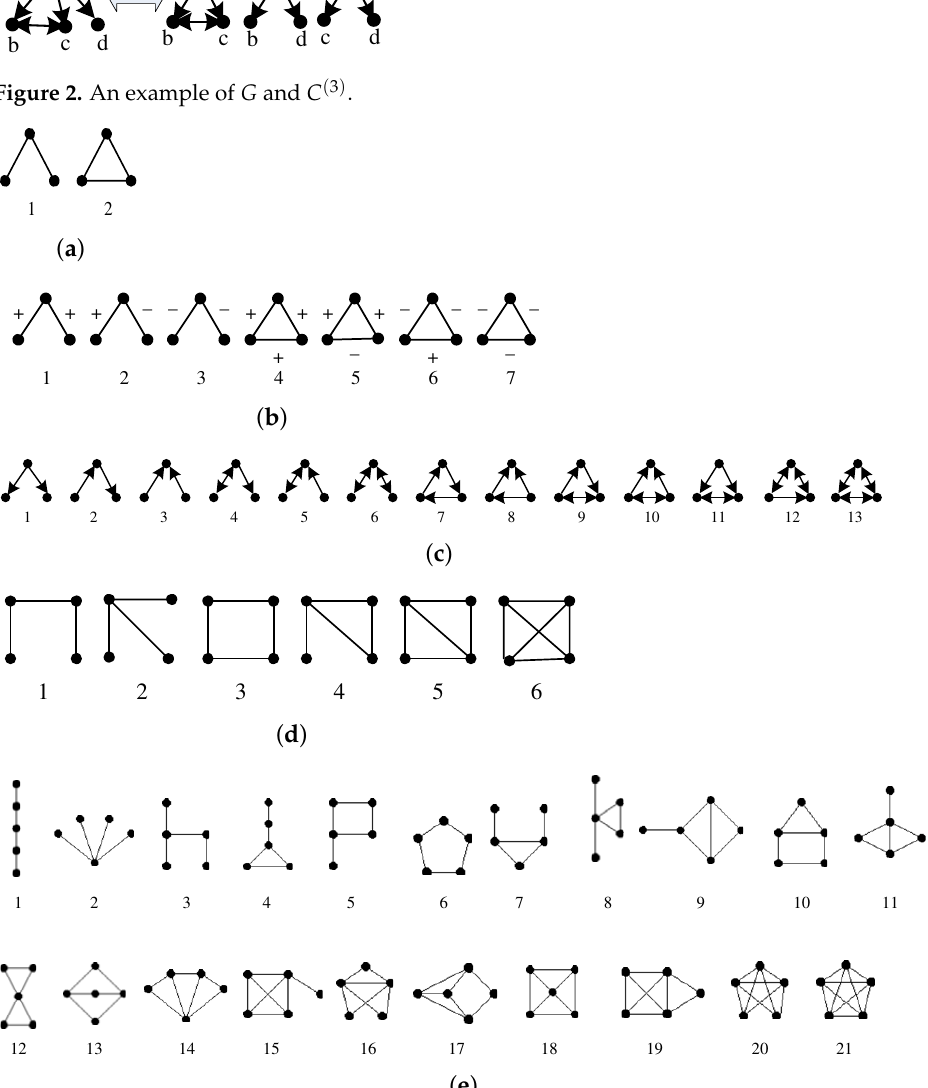
Figure 3. All three-node, four-node, and five-node motifs (the numbers are the motif IDs): ( a ) three- node undirected motifs; ( b ) three-node signed and undirected motifs; ( c ) three-node directed motifs; ( d ) four-node undirected motifs; ( e ) five-node undirected